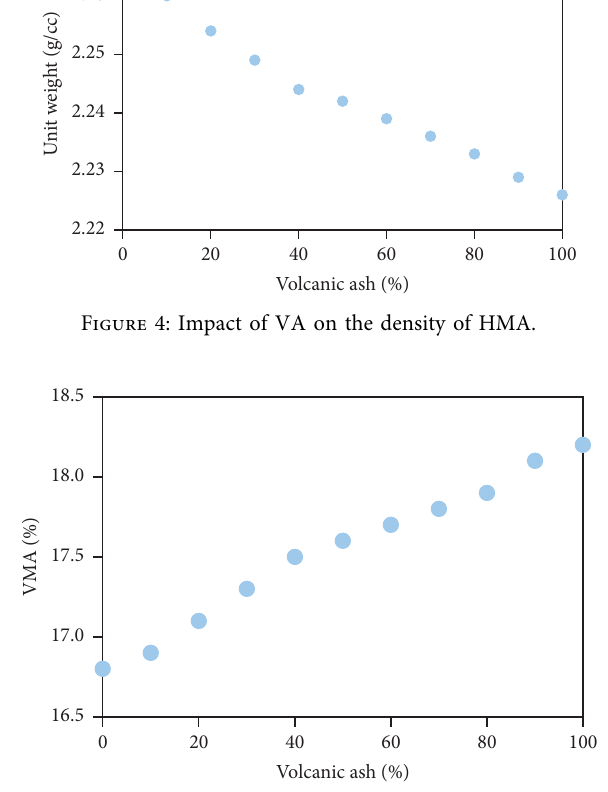
Figure 5: Impact of VA content on Marshall VMA of